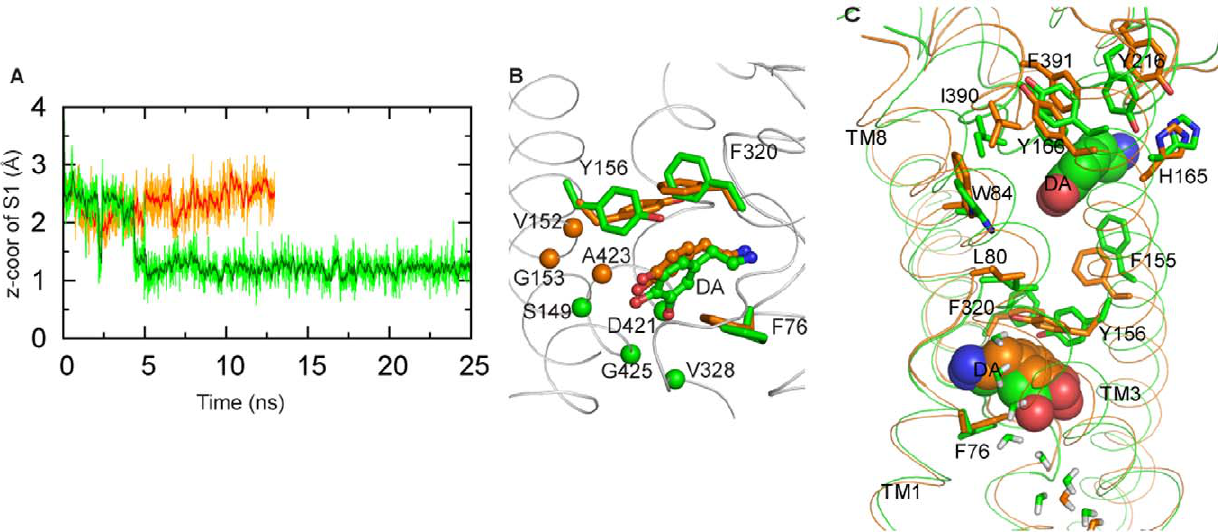
Figure 2. The allosteric effect of S2 on the S1 site. ( A ) Change in position of the DA substrate in the S1 site during equilibration of the S1,S2- DAT model. The green trace shows that the Z-coordinate of DA (center of mass) decreases by , 1.5 A˚ (i.e., DA is shifted downward toward the intracellular side), compared to its position in S1-DAT (orange trace). ( B ) The positional changes of DA, the rotamer changes of F76 1.42 , Y156 3.50 and F320 6.53 , and the changes in the composition of the S1 site in S1-DAT (residues rendered in orange) compared to S1,S2-DAT (in green). Note that in S1,S2-DAT, the substrate interacts more (i.e., a higher percentage of time) with S149 3.43 , V328 6.61 , and G425 8.63 , and establishes a new interaction with D421 8.59 (C a atoms shown as orange spheres) while losing interactions with V152 3.46 , G153 3.47 and A423 8.61 (C a atom shown as green spheres). ( C ) The residues forming an interaction network involved in conformational transitions between S1-DAT (orange) and S1,S2-DAT (green). Residues I390 EL4 and F391 EL4 are in contact with DA in the S2 site. Note that changes in W84 1.50 , L80 1.46 , Y156 3.50 and F320 6.53 are coordinated with I390 EL4 and F391 EL4 (Table 1).